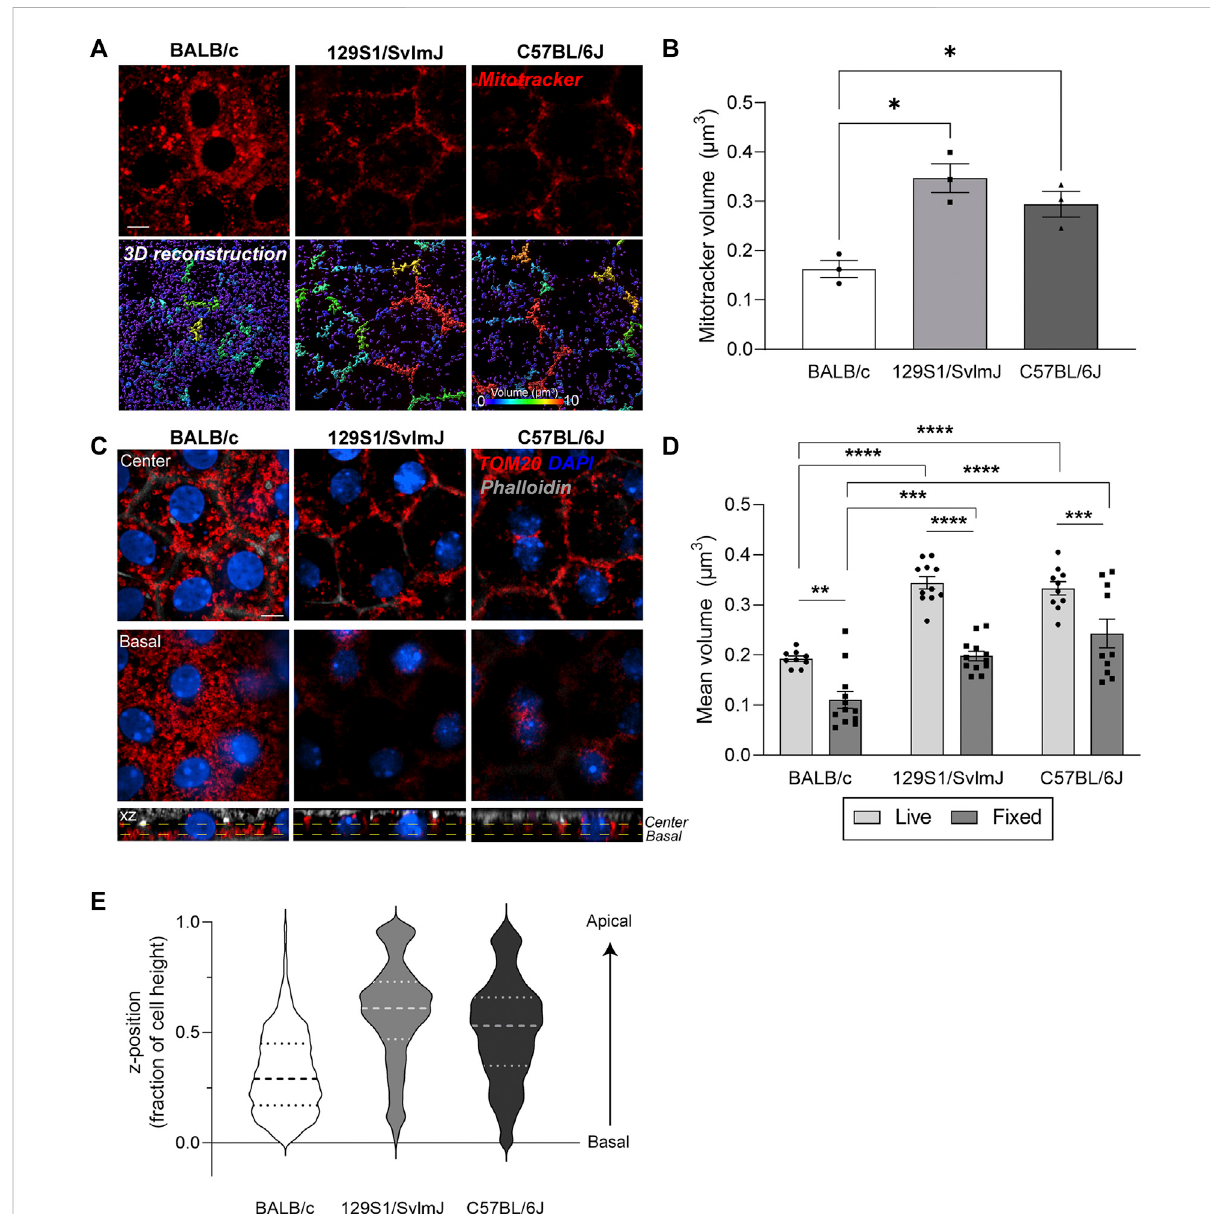
FIGURE 5 Live imaging of mouse RPE fl atmounts reveals impaired mitochondrial integrity in albino mouse RPE. (A) Stills from live imaging of Mitotracker deep red (red) in RPE fl atmounts from albino BALB/c, pigmented 129S1/SvlmJ, and pigmented C57BL/6J mice. Lower panel: 3D reconstructions of mitochondria. Scale bar = 5 µM. Warmer colors indicate larger volumes or integrated mitochondria, cooler colors indicate smaller volumes or fragmented mitochondria. (B) Quanti fi cation of mitochondrial volumes in (A) . Mean ± SEM. n = 3 mice per strain. * p = 0.0215 between BALB/c and 129S1/SvlmJ; p = 0.0425 between BALB/c and C57BL/6J by one-way ANOVA. (C) Immuno fl uorescence images of paraformaldehyde- fi xed mouse RPE fl atmountsstained forTOM20(red).Top:Single-plane viewacrossthecenteroftheRPE;Middle: Single-plane view acrossthebasalside of the RPE; Lower panel: x-z view showing mitochondrial distribution along the height of the RPE. Phalloidin (grey) labels the actin cytoskeleton and microvilli attheapicalsurfaceoftheRPE.Alsosee SupplementaryMoviesS6 – 8. (D) Quanti fi cationofmitochondrialvolumesinRPE fl atmountsfrom live and fi xed imaging. Mean ± SEM., **, p = 0.023; ***, p = 0.0009; **** p < 0.0001. Two-way ANOVA was used for comparison between live and fi xed imaging, one-way ANOVA was used for comparison within live and fi xed imaging respectively. Representative data from ~60 cells per mouse, data based on n = 3 mice per strain. (E) Representative violin plot of individual mitochondria z-positions normalized to cell height (0 = bottom-most z-position, 1 = top-most z-position). Dashed lines represent quartiles and medians of the respective dataset.